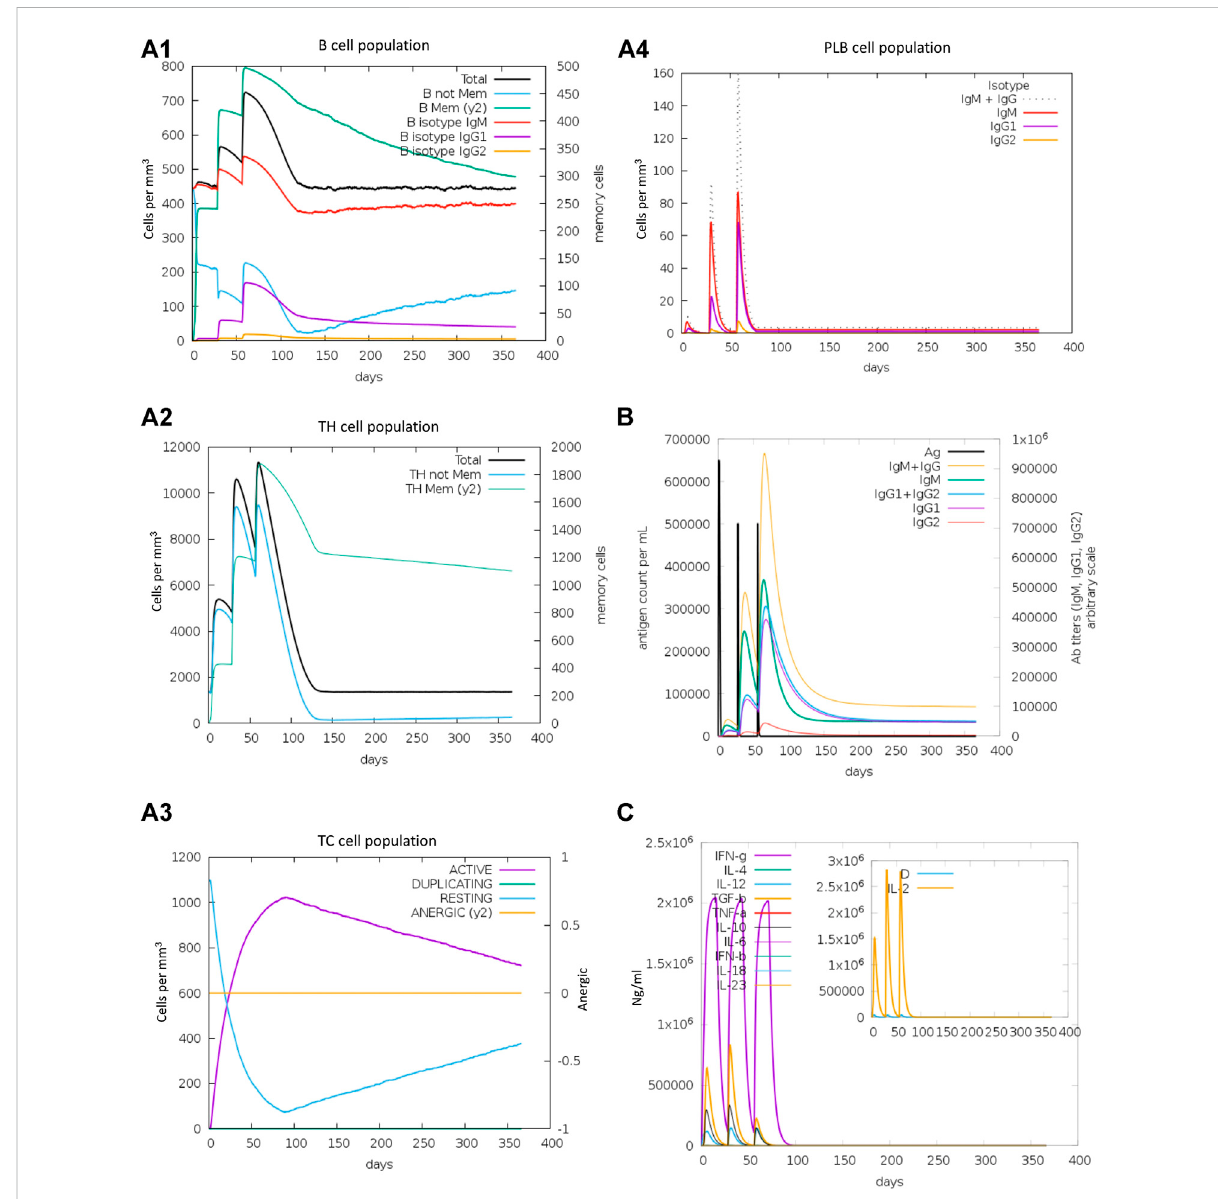
FIGURE 15 Immuneresponsesimulationsofre fi nedRBD – ferritinnanoparticlevaccine. (A1) Bcellpopulation. (A2) THcellpopulation. (A3)